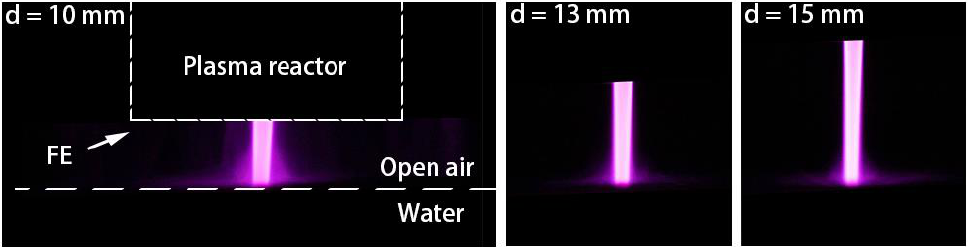
Figure 2. Discharge images of FEGLD plasma with variations in the discharge gap.